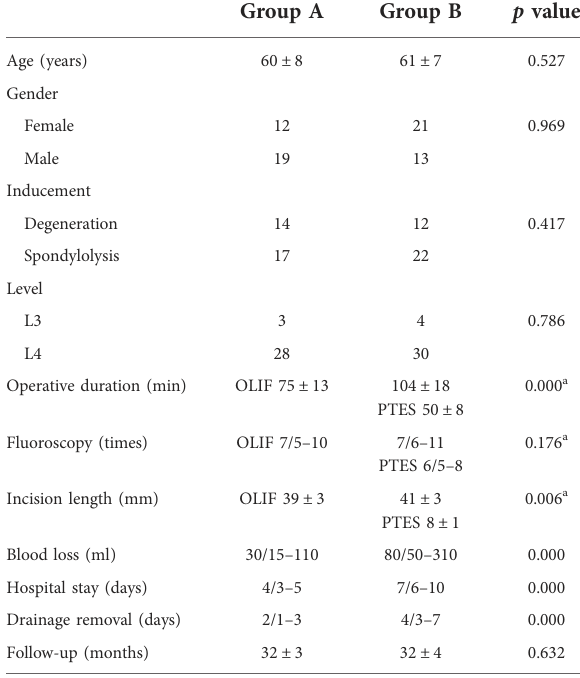
TABLE 1 Comparison of clinical data between group A and